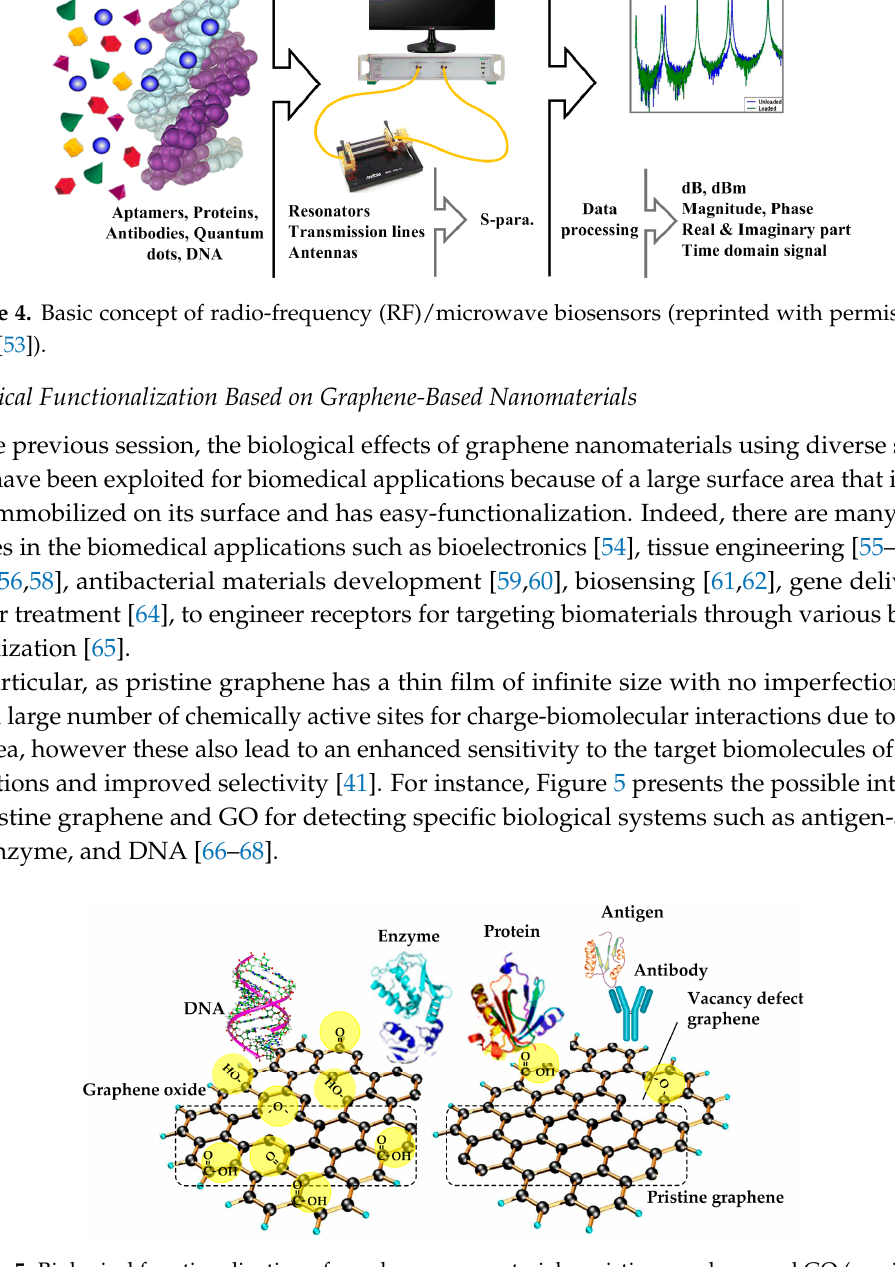
Figure 5. Biological functionalization of graphene nanomaterials: pristine graphene and GO (reprinted with permission from [41]).